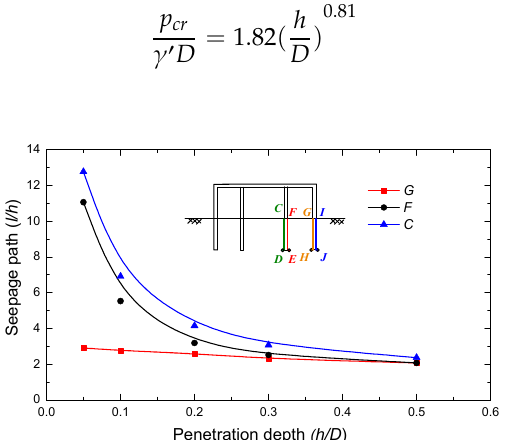
Figure 15. Relationship between the seepage path and penetration depth. J. Mar. Sci. Eng. 2020 , 8 , 368